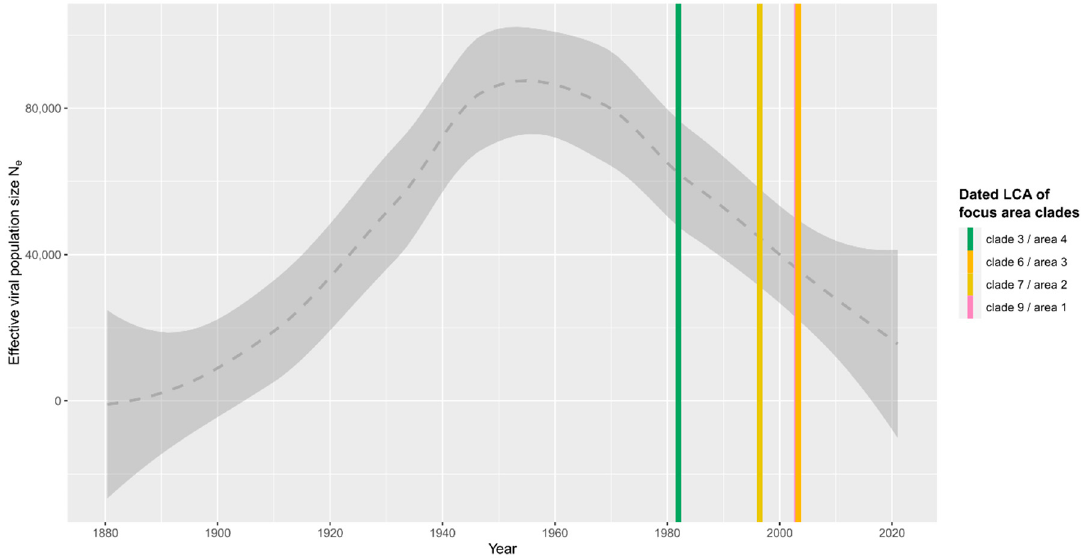
Figure 6. Coalescent Bayesian skyline plot modelling the TBEV population dynamics based on the chronogram of the E gene region 1 shown in Figure 5. The skyline (gray dashed line) was modelled with TreeTime, assuming 50 gen/year and approximate confidence bounds (±2 standard deviations; gray band). Colored vertical lines mark the estimated divergence times of the independent LCAs of the four TBEV clades/focus areas.